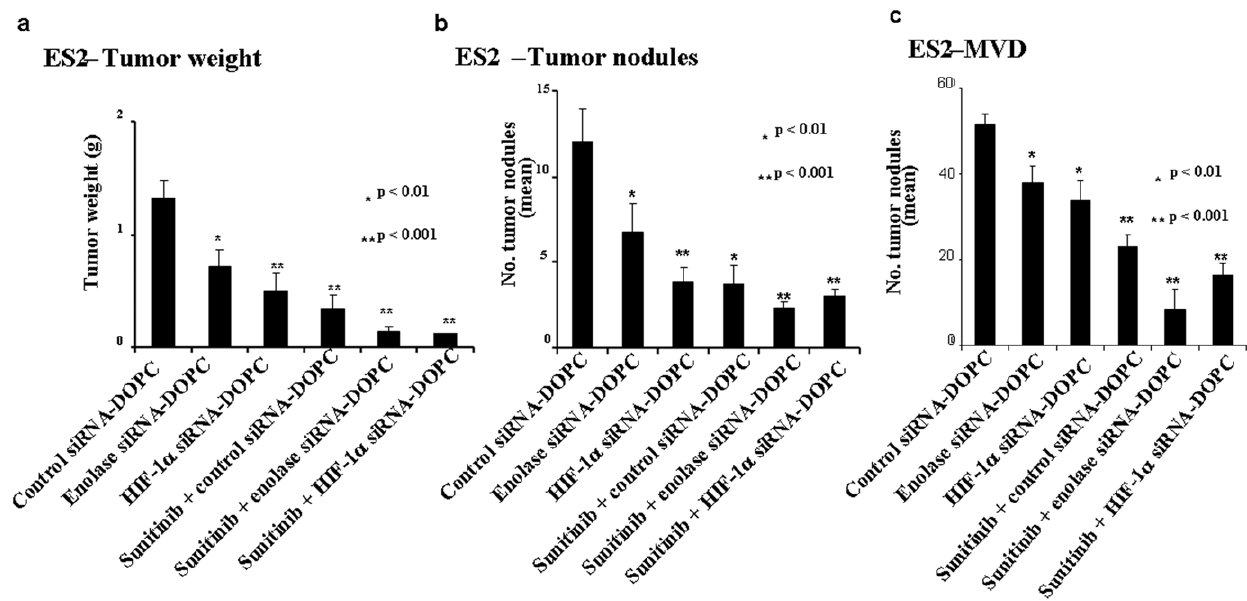
Figure 4. Effect of Enolase or HIF1 a siRNA-DOPC ± sunitinib on ovarian clear cell tumor progression in the female athymic nude mouse model. ( a ) Tumor weight: ES2 cells (1 6 10 6 cells/mouse) were injected intraperitoneal into mice. The mice were treated with control, Enolase or HIF1 a siRNA-DOPC 6 sunitinib (n=10/group). Immunohistochemical staining for CD31 antigen was performed on frozen slides of tumor to evaluate the number of tumor nodules ( b ) and tumor microvessel density (MVD) ( c ). (See Materials and Methods section for